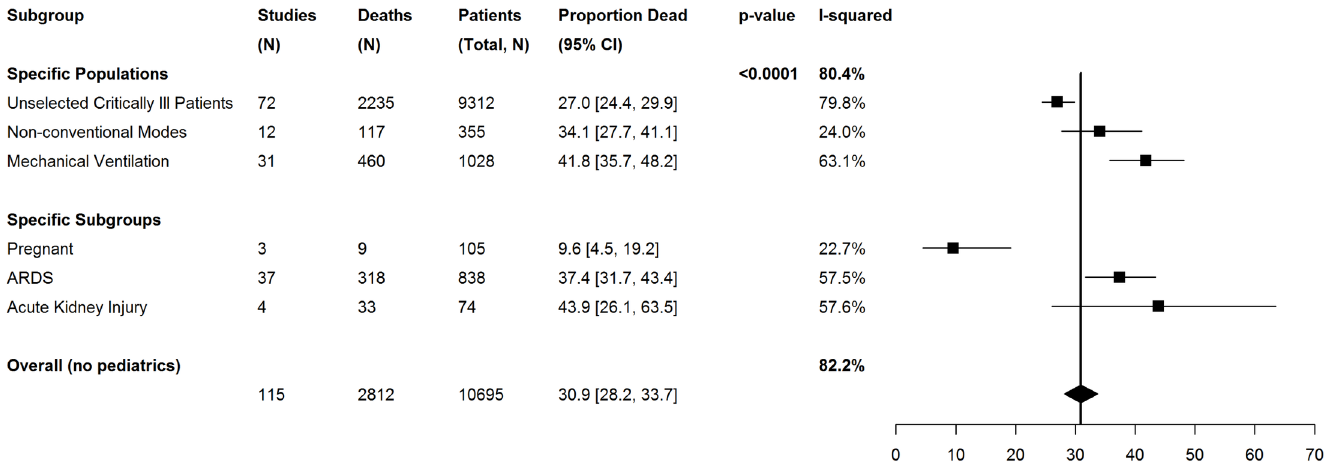
Fig 4. Differences in reported mortality based on subgroups of patients with different severity of illness (need for mechanical ventilation), critical illness associated organ failure (ARDS; AKI) or co-presenting conditions (pregnancy). The black squares represent the point estimate and 95% confidence intervals (CIs) around the mortality for each subgroup. The black diamond is the summary or overall combined estimate of mortality associated with the 2009 Influenza A (H1N1)